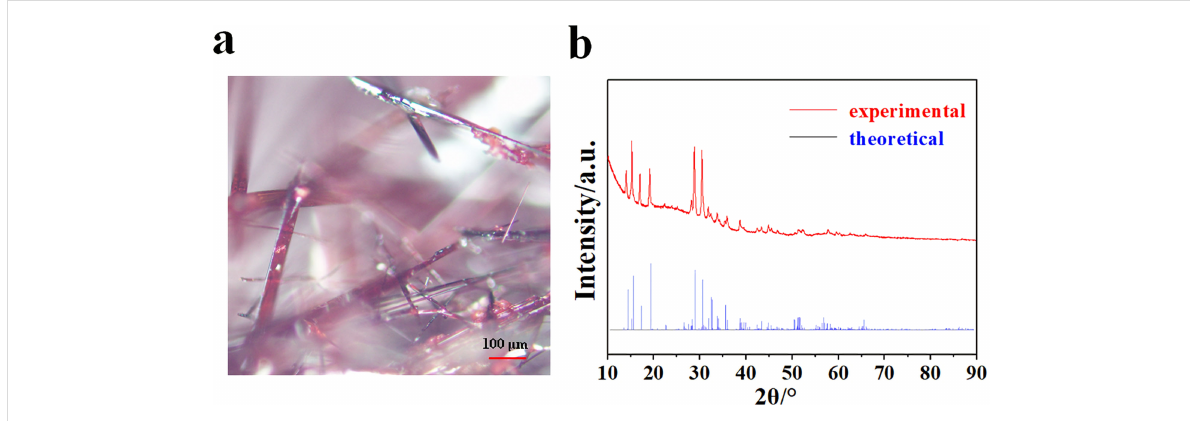
Figure 1: (a) Optical microscopy result of KP 15 bulks. (b) XRD results of KP 15 bulks.